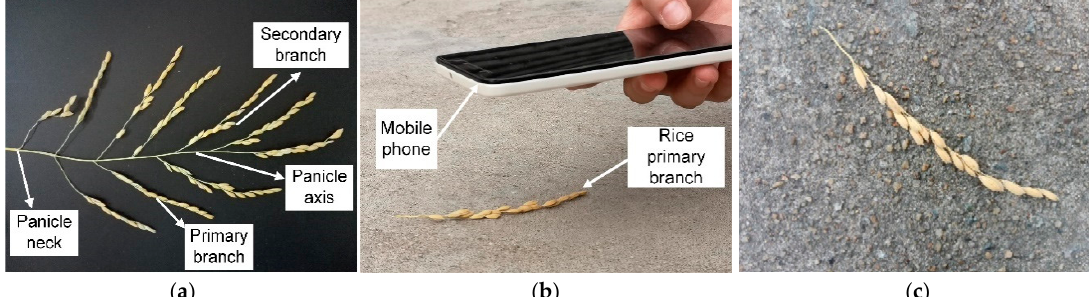
Figure 1. Illustration of the process of image capturing: ( a ) structure of a rice panicle; ( b ) rice primary branch and image taking with a mobile phone; ( c ) image captured showing the rice primary branch.